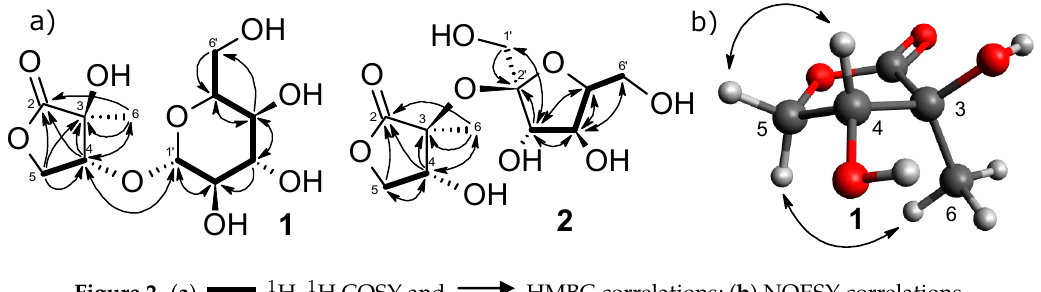
Figure 2. ( a ) 1 H– 1 H COSY and HMBC correlations; ( b ) NOESY correlations.